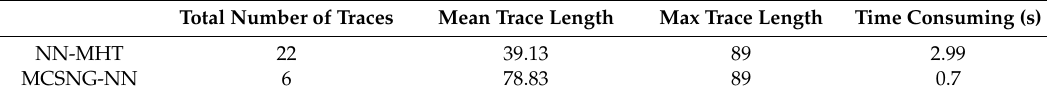
Figure 11. Tracing results comparison of both algorithms: ( a ) NN-MHT tracing result; ( b ) MCSNG- NN tracing result. tracing result. Table 4. The performance indexes of NN-MHT and MCSNG-NN. Table 4. The performance indexes of NN-MHT and MCSNG-NN.